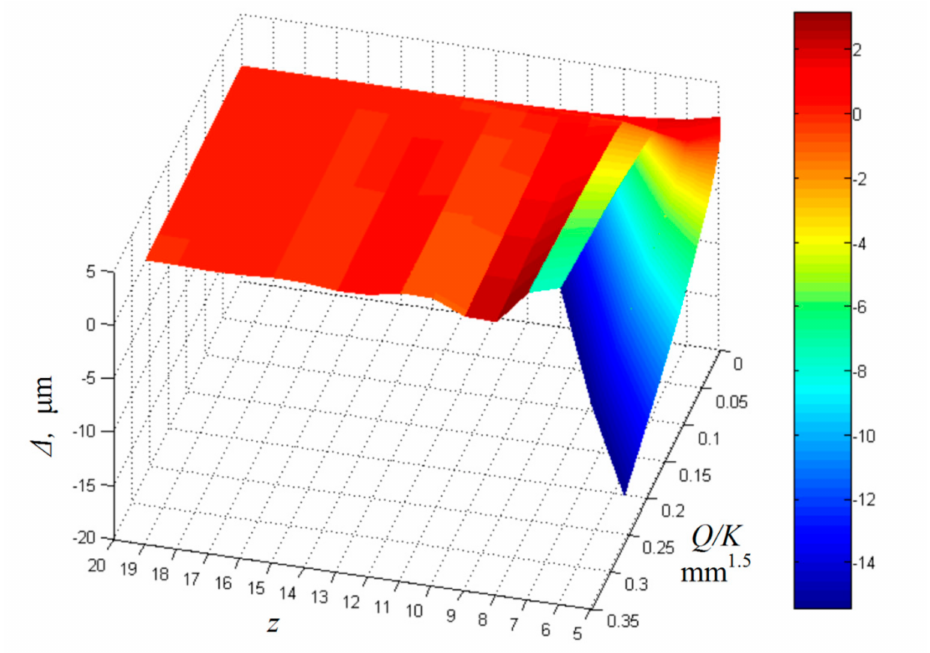
Figure 13. Three-dimensional dependence of the total amplitude of VC vibration ( ∆ ) on the total number of rolling elements ( z ) and the level of external load ( Q